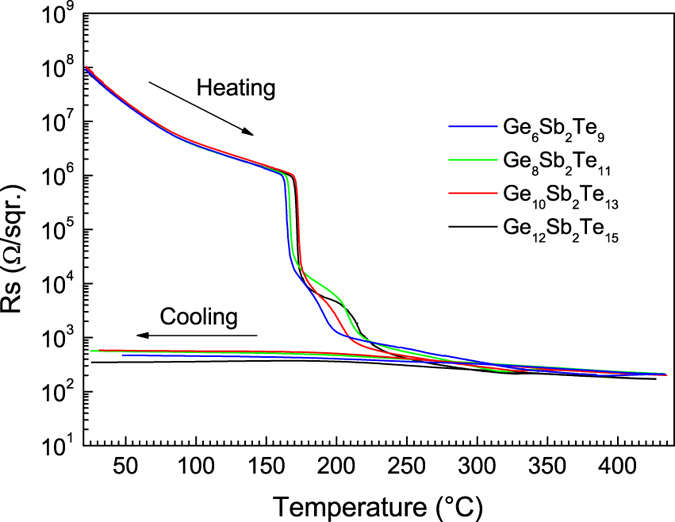
Sheet resistance of as-deposited GST layers (deposited on microscope glass substrates) on heating followed by cooling: Ge6Sb2Te9 (blue), Ge8Sb2Te11 (green), Ge10Sb2Te13 (red), and Ge12Sb2Te15 (black).